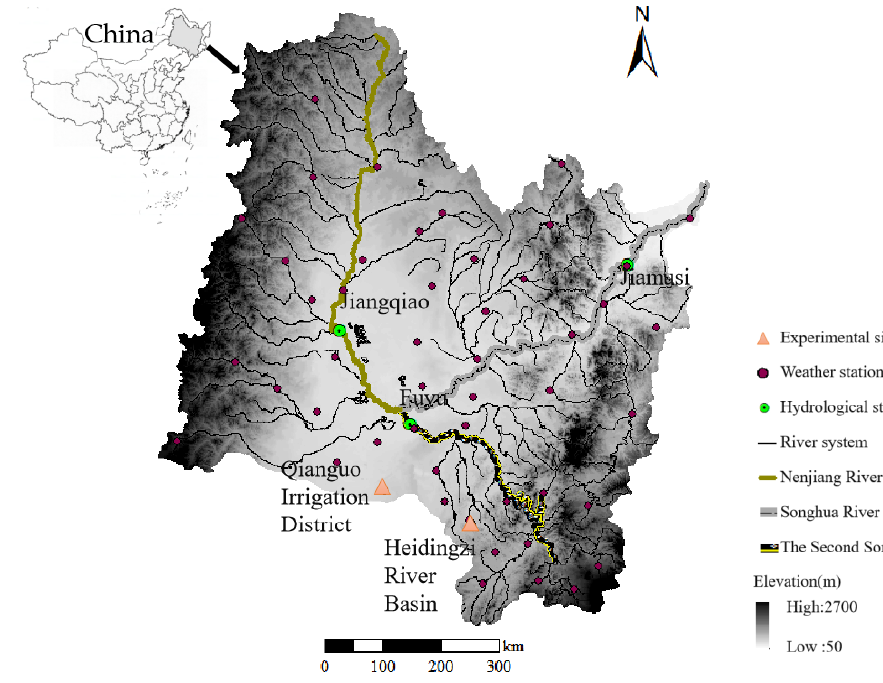
Figure 1. Overview of the